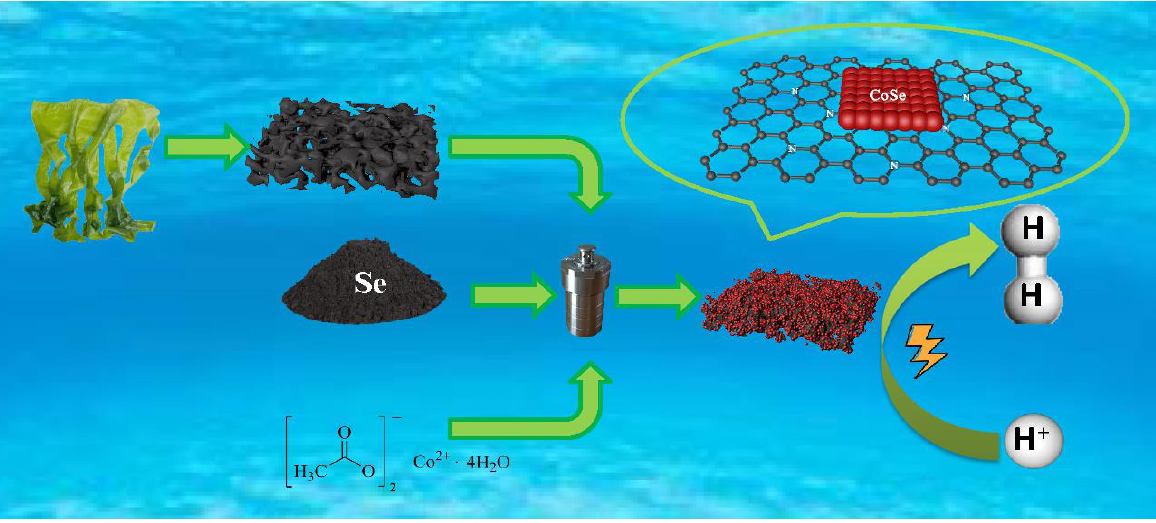
Figure 1. Schematic illustration of the synthesis of CS/yNC@X.